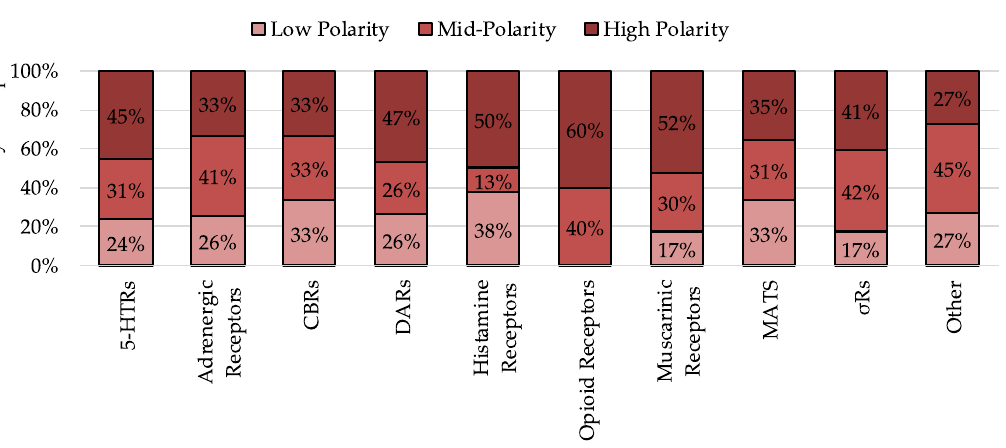
Figure 8. Percent of hits at each receptor group originating from low polarity (A, B, C), mid-polarity (D, E, F), and high polarity (G, H, I) fractions. Most hits come from high polarity fractions.